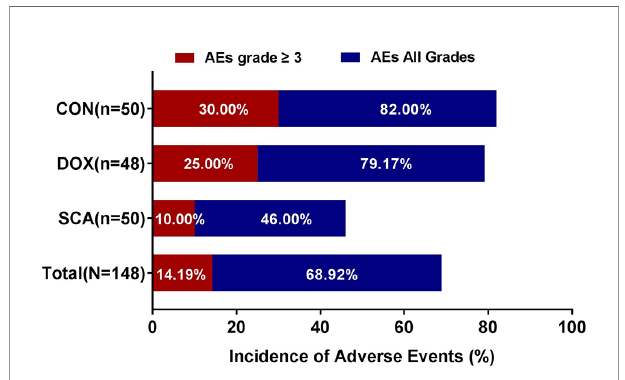
FIGURE 3 | Incidence of Adverse Events in each group